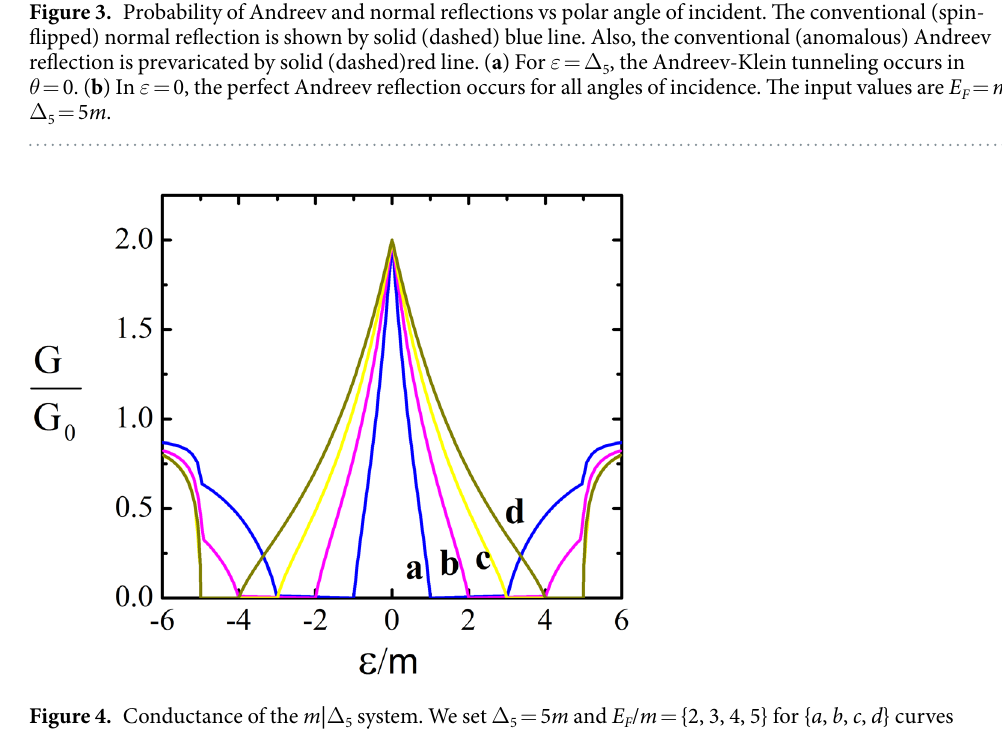
Figure 4. Conductance of the m | Δ 5 system. We set Δ 5 = 5 m and E F / m = {2, 3, 4, 5} for { a , b , c , d } curves